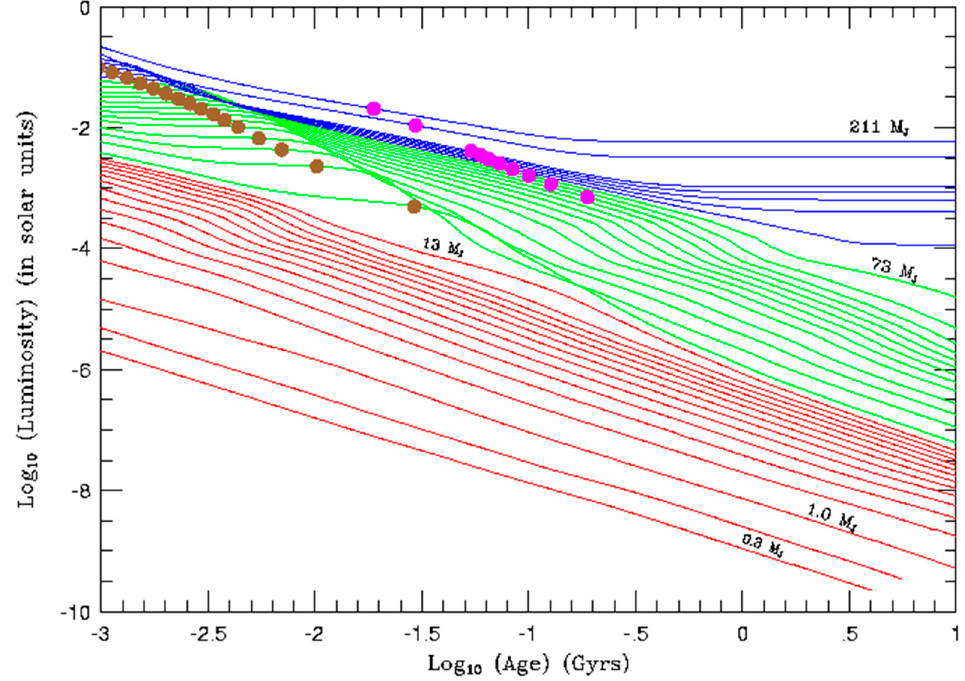
Figure 5. Cooling curves for M dwarfs (blue), brown dwarfs (green), and “extrasolar giant planets” (red) according to the evolutionary models of [84]. Magenta and brown circles indicate the times when deuterium fusion ends and grain formation begins, respectively. “Planetary-mass objects” of a few megayears can have luminosities greater than low-mass stars of a few gigayears. Heritage scientific graphic downloaded from Adam Burrows’ home page [137].